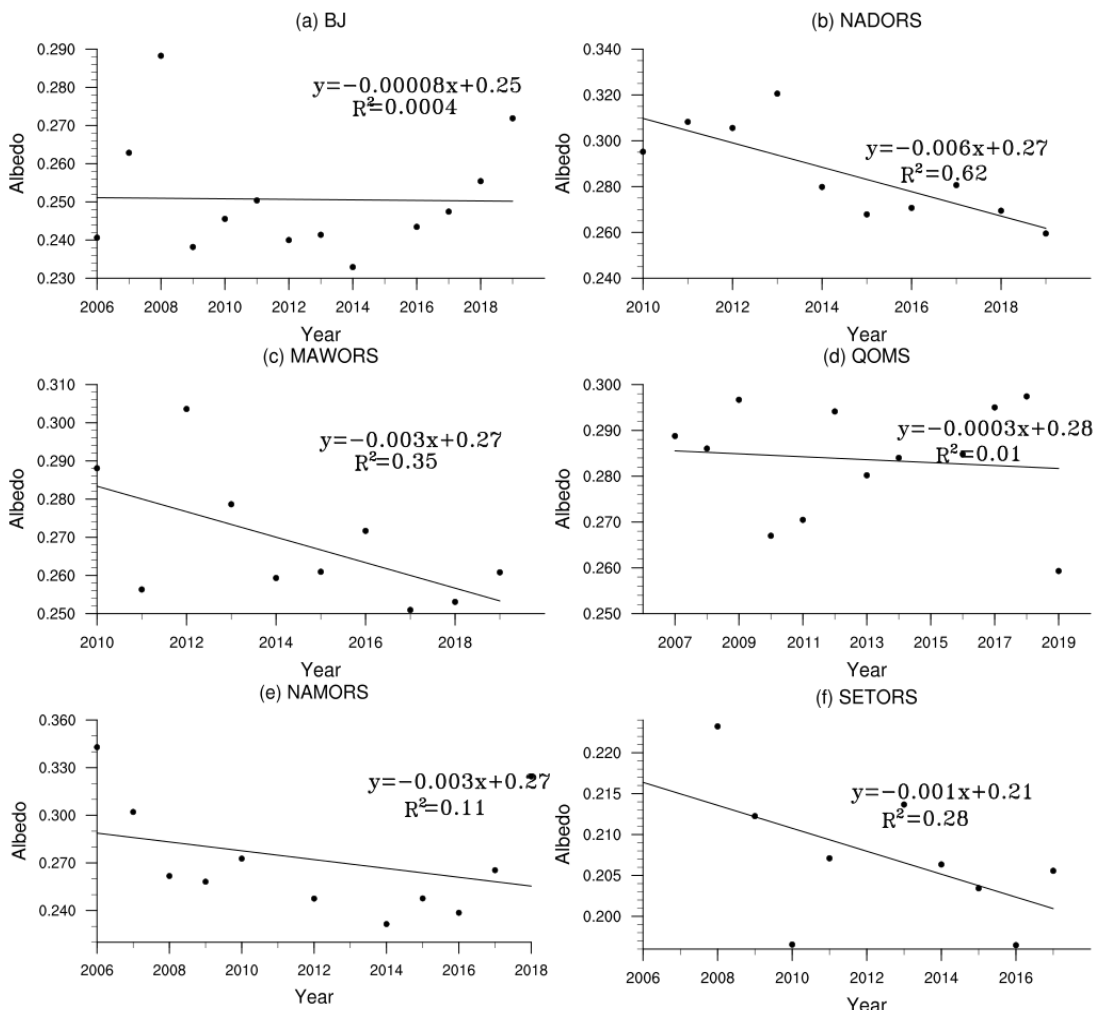
Figure 14. Interannual variation of surface albedo at each station.